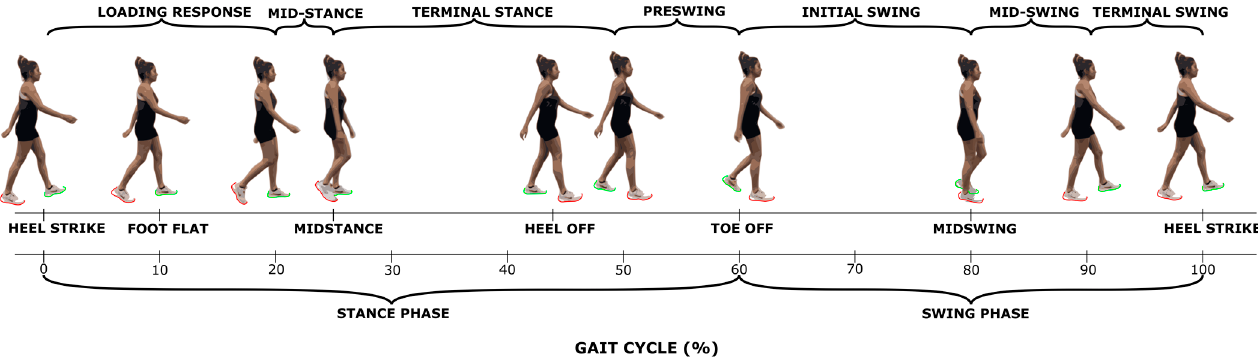
Figure 2. Representation of a gait cycle of the foot highlighted in green, along with the classically considered gait events and phases.